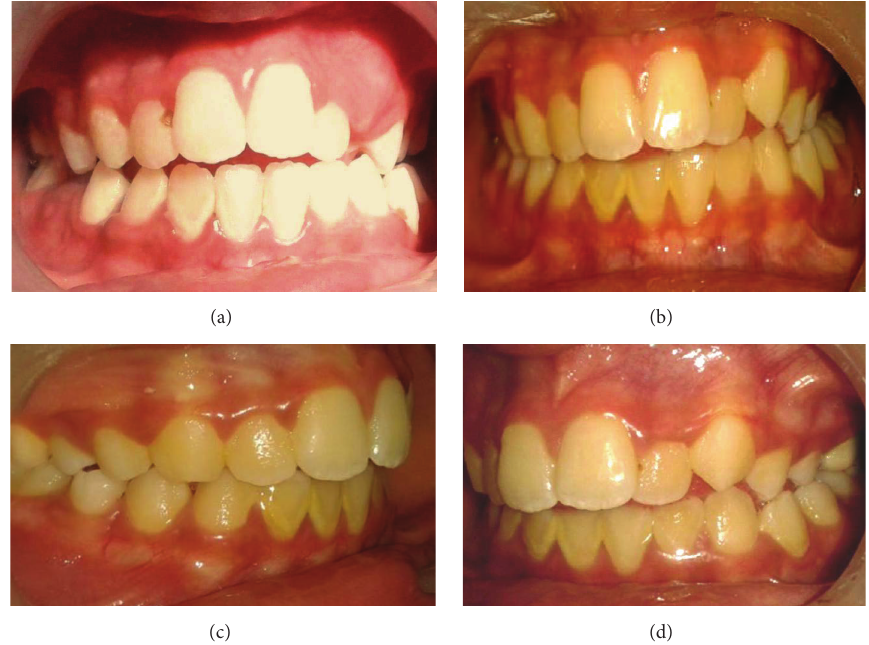
Figure 2: Preoperative condition indicates (a) anterior open bite, (b) compensatory tongue thrust, and ((c) and (d)) unilateral (left) posterior crossbite and palatally locked lateral